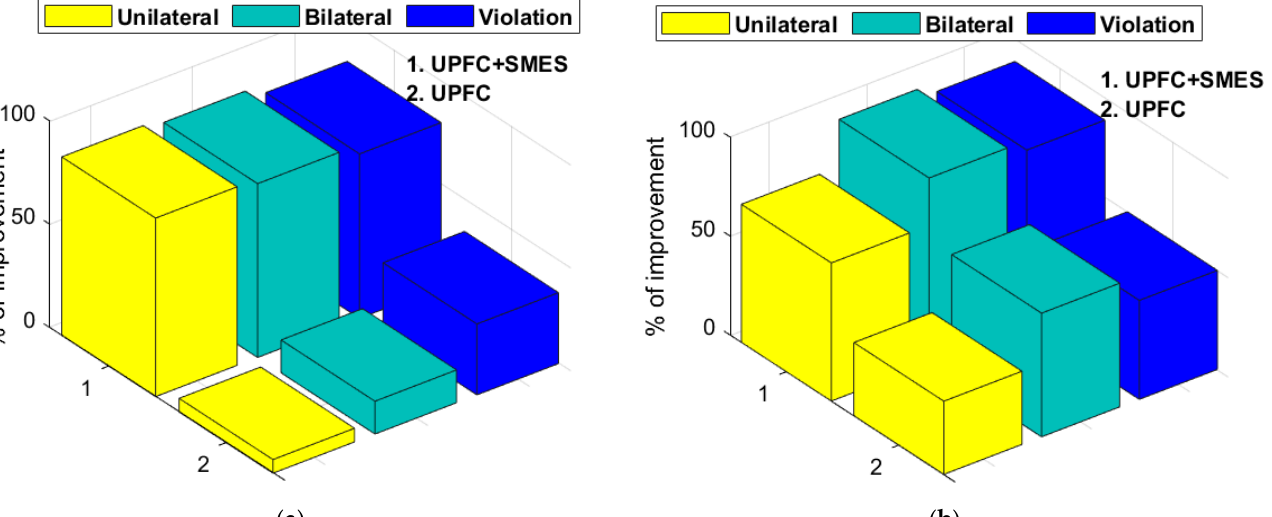
Figure 16. Comparison of the impact of ancillary device on deregulated power system operation in the case of three contracts with respect to the frequency deviation—percentage improvements rela- tive to the case without ancillary: ( a ) frequency improvement in area-1; ( b ) frequency improvement in area-2.